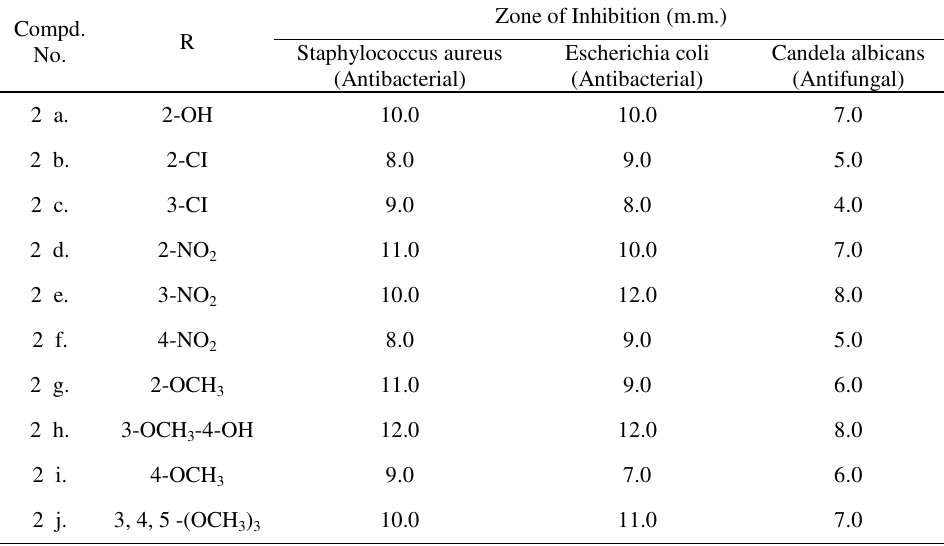
Table 8 . ANTIMICROBIAL DATA OF COMPOUNDS [2(a-j)]